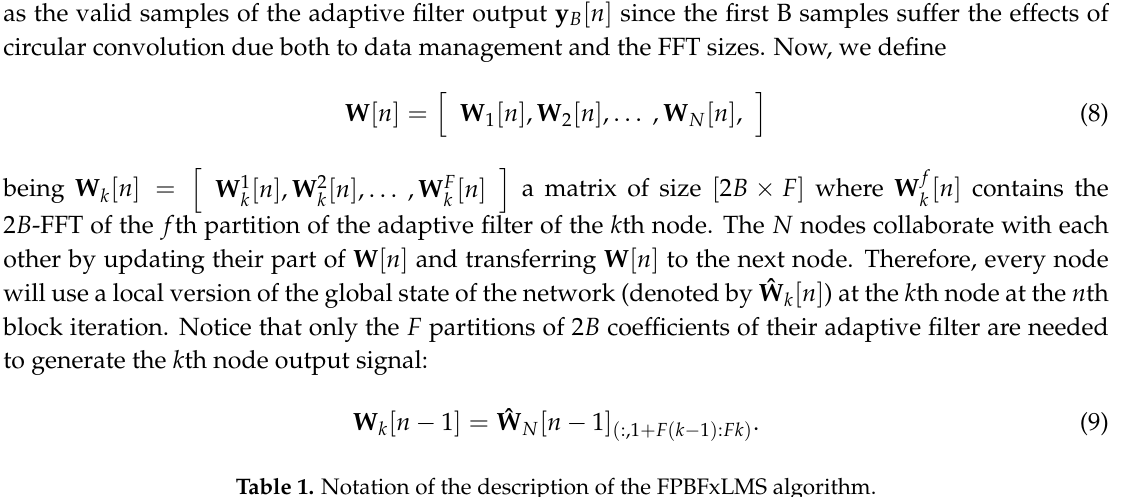
Table 1. Notation of the description of the FPBFxLMS